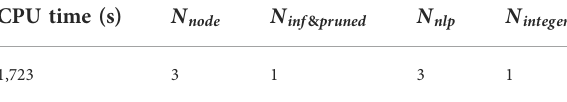
TABLE 11 Computational performance for Example 4.